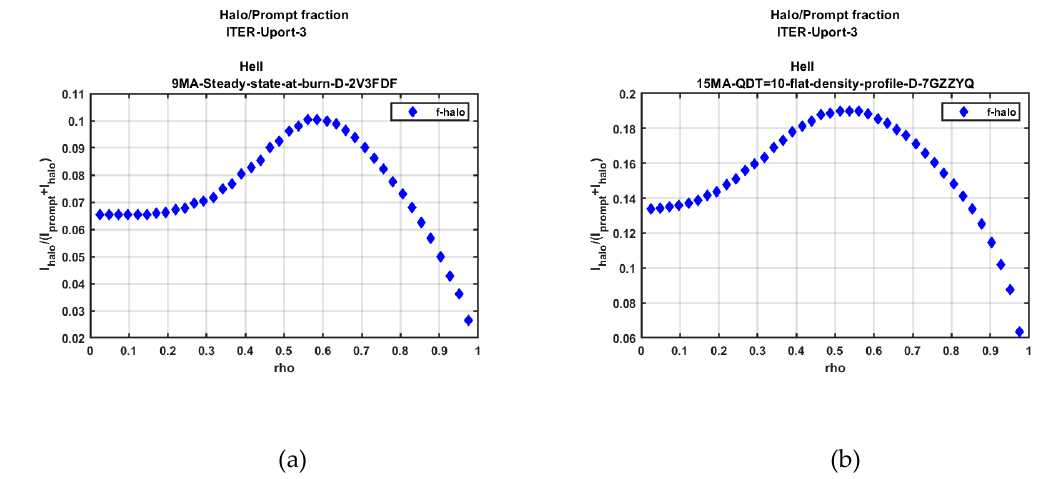
Figure 10. ( a ) Prompt HeII CX spectrum, synthetic line of sighted integrated halo spectrum and Gaussian prompt spectrum normalized to halo amplitude. Ratio I halo /(I prompt +I halo ) = 0.07for the 9 MA-steady-state-at-burn scenario; ( b ) Prompt HeII CX spectrum, synthetic line of sighted integrated halo spectrum and Gaussian prompt spectrum normalized to halo amplitude Ratio I halo /(I prompt +I halo ) = 0.16. for the 15 MA flat density scenario.